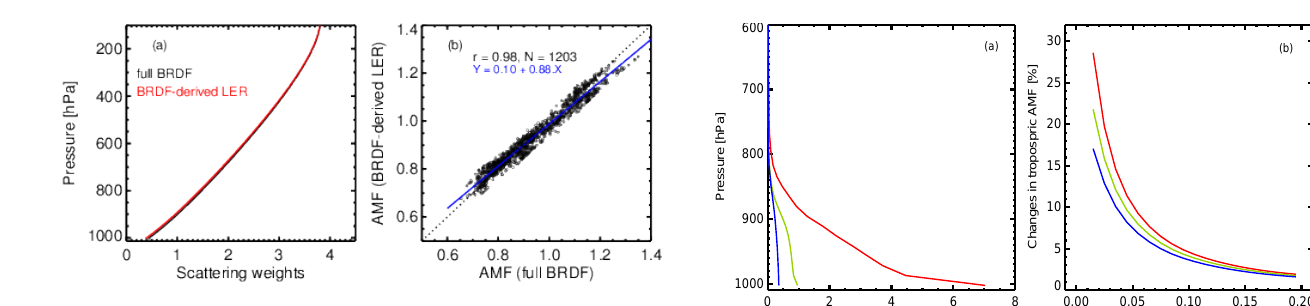
Figure 12. (a) Scattering weights calculated for an OMI pixel with the following observation angles: SZA=53.1 ◦ , VZA=54.1 ◦ , and relative azimuth angle RAZ=60.3 ◦ . (b) AMF calculated with full BRDF vs. BRDF-derived LER for OMI measurements over the eastern US on 14 November 2006. A regression line is shown in blue. The data are for clear skies.